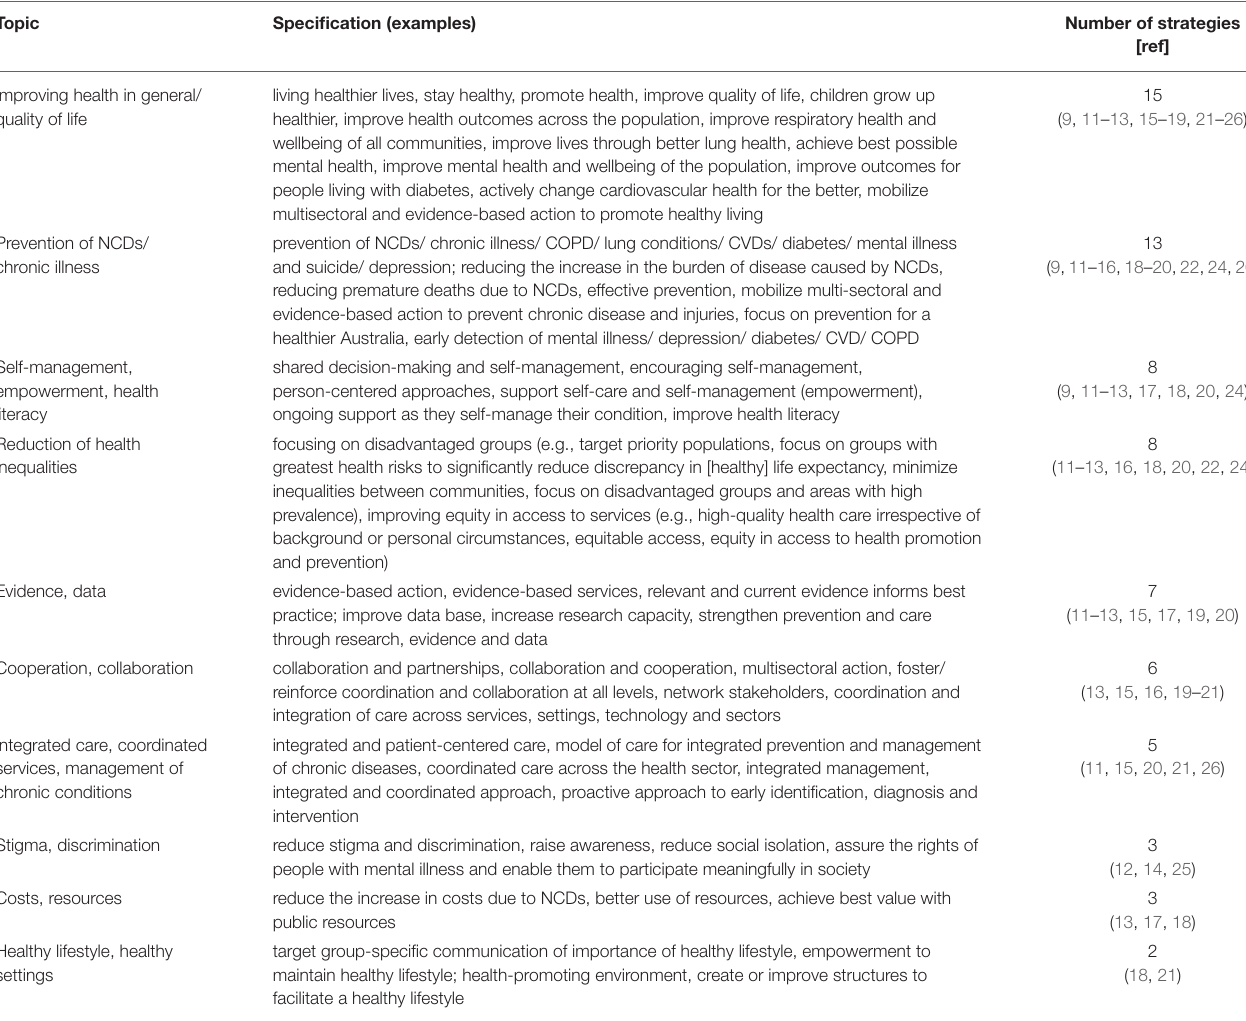
TABLE 3 | Topics addressed in the aims/objectives of included